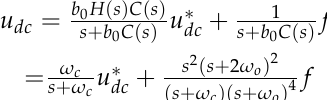
( b ) Figure 10. Disturbance rejection performance under different bandwidths: ( a ) c ω is fixed at 10 rad/s; ( b ) o ω is fixed at 10 rad/s.